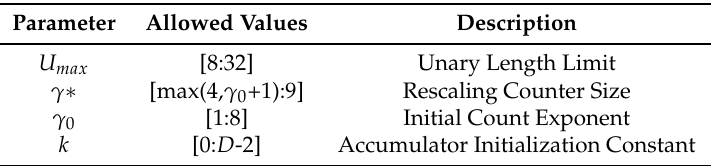
Table 1. Sample-adaptive encoder parameters.